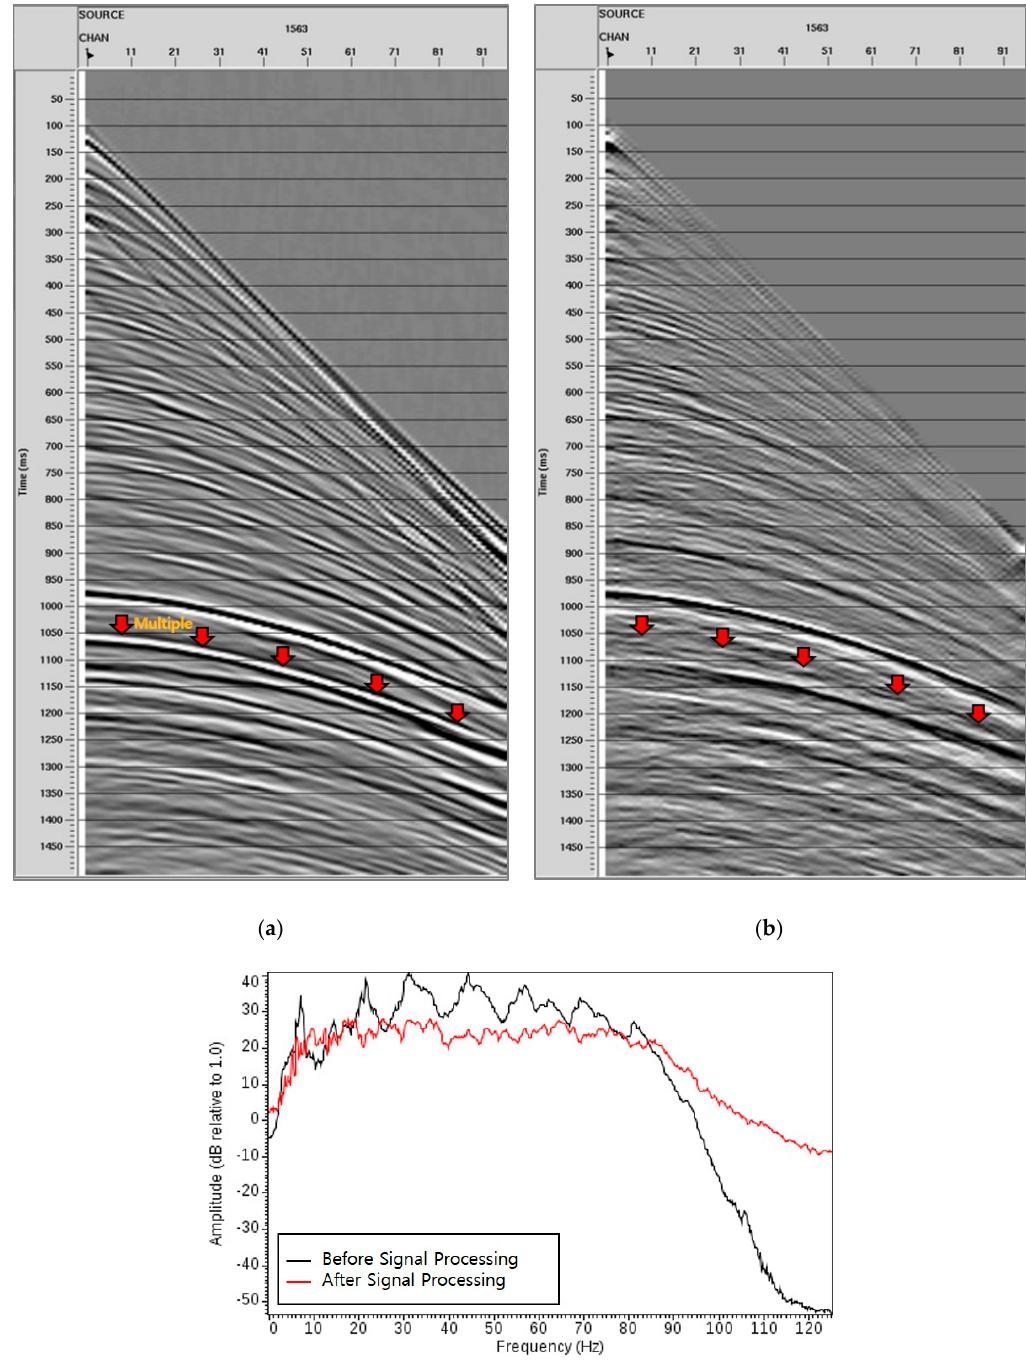
Figure 4. Shot gathers ( a ) before and ( b ) after the signal processing. ( c ) Amplitude spectra before (black line) and after (red line) the signal processing.